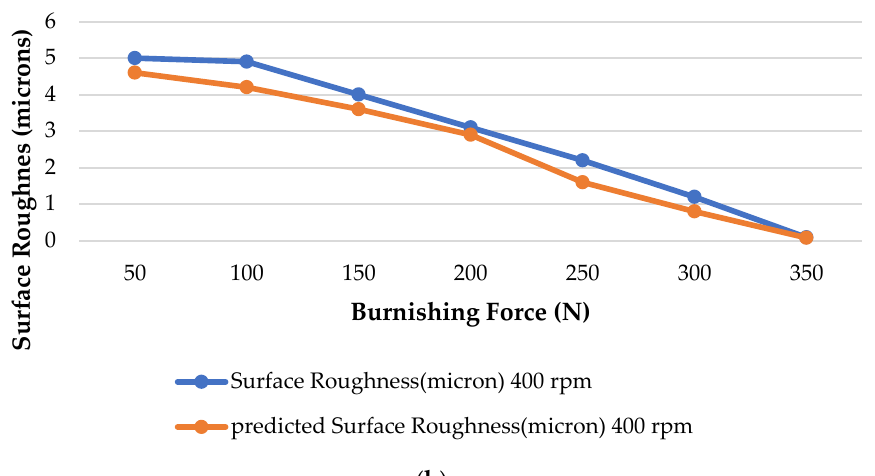
Figure 13. Comparison between experimental results and mathematical results. ( a ) surface roughness at 600 rpm, ( b ) surface roughness at 400 rpm.